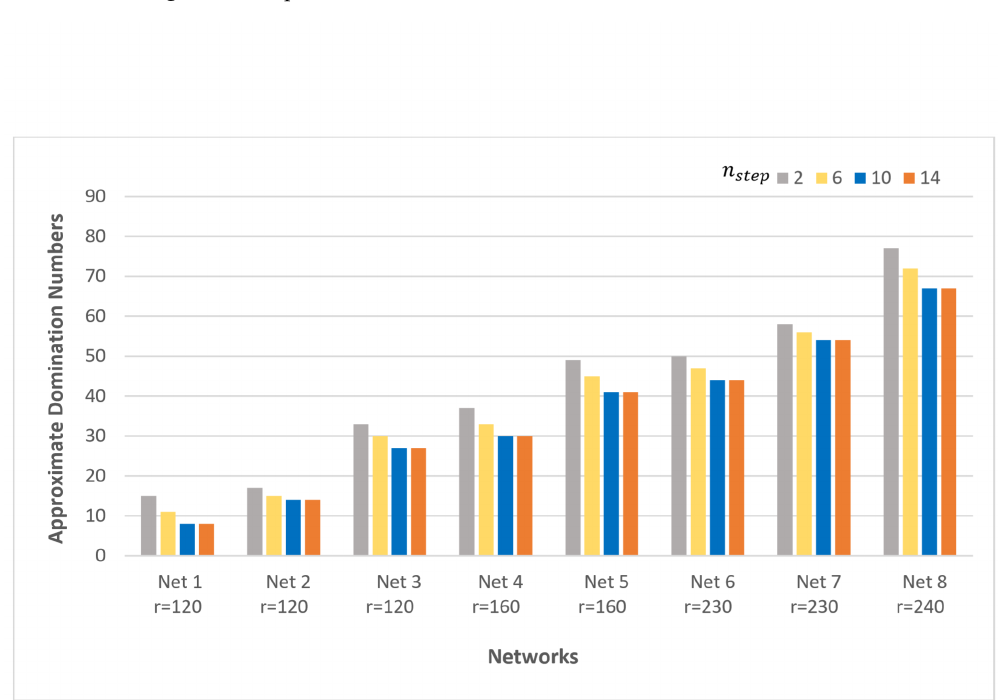
Figure 3. The performance of the ASS-MCDS with different n step